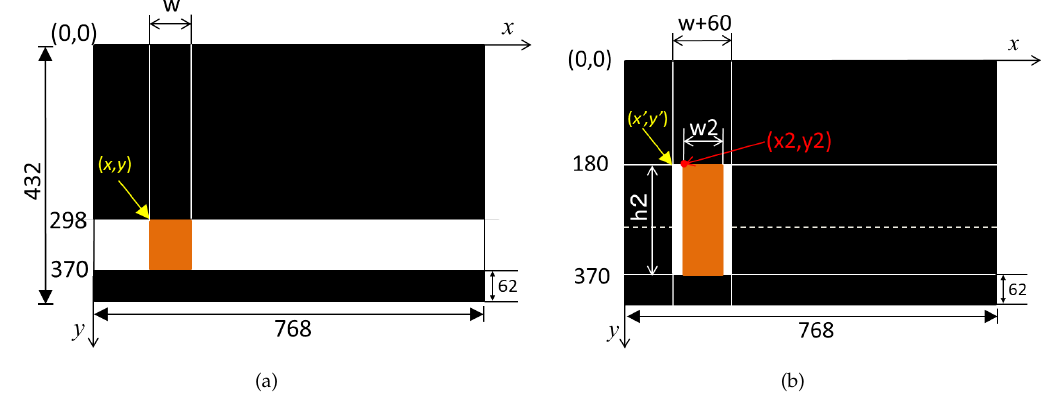
Figure 7. Search range in small range and expanded range: ( a ) search range for initial detection; and ( b ) expanded range based on coordinates retrieved from initial detection.